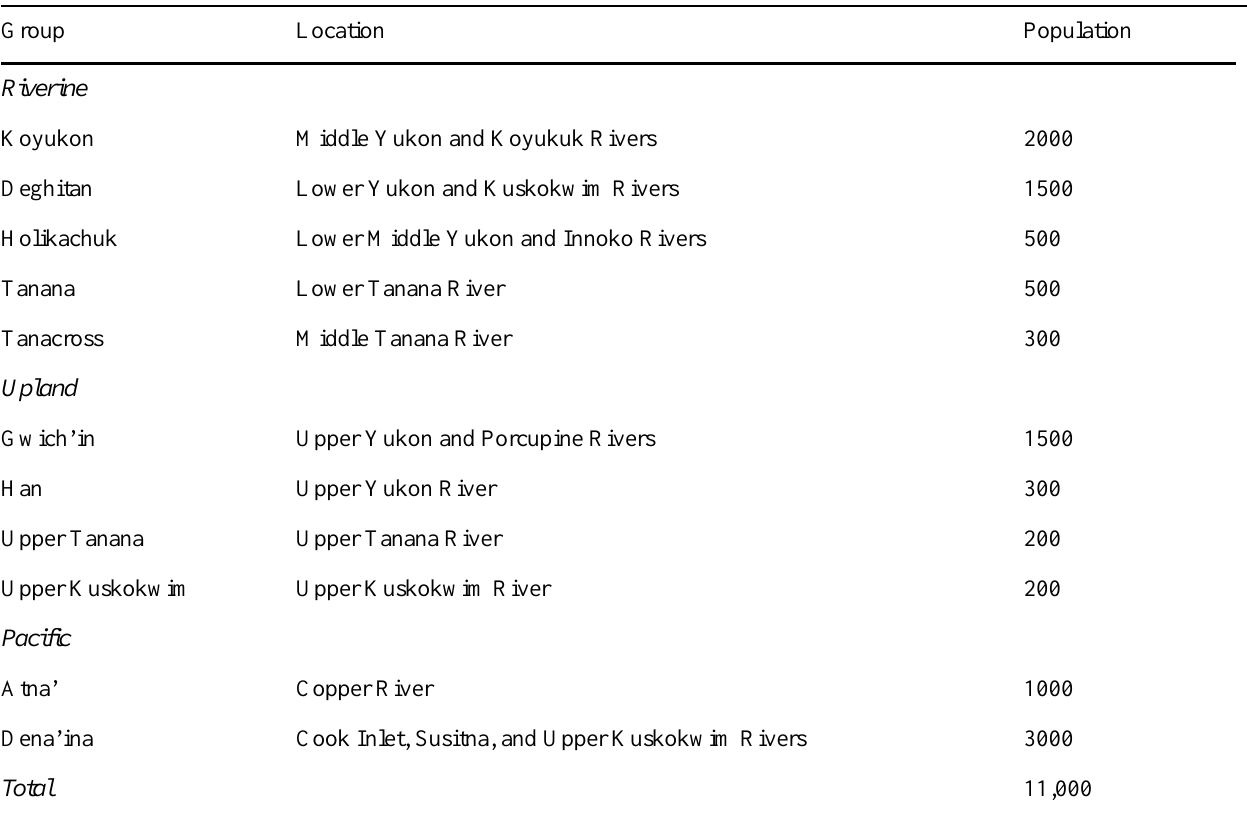
Table 1. Athabaskan groups and estimated population at contact (Langdon 1992).